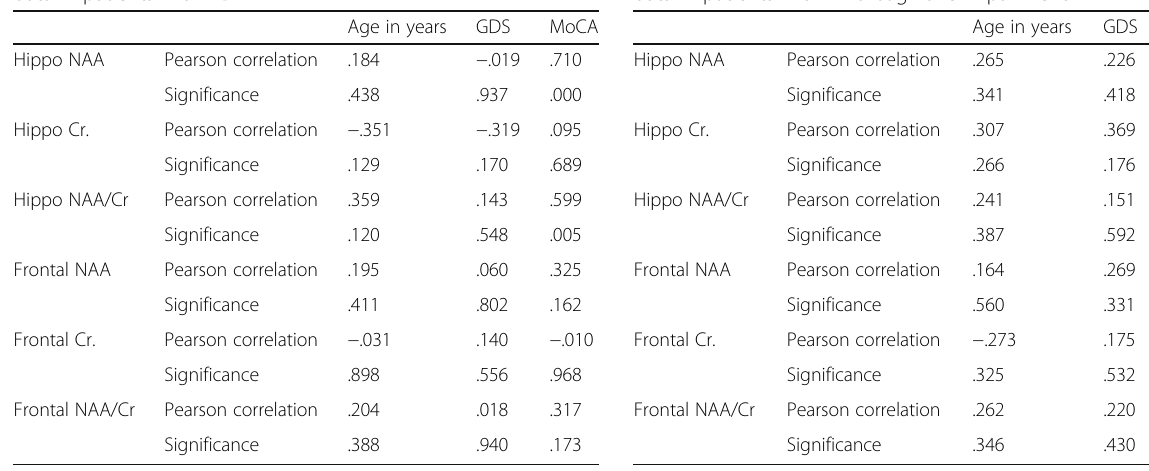
Table 4 Correlations between age, clinical, and